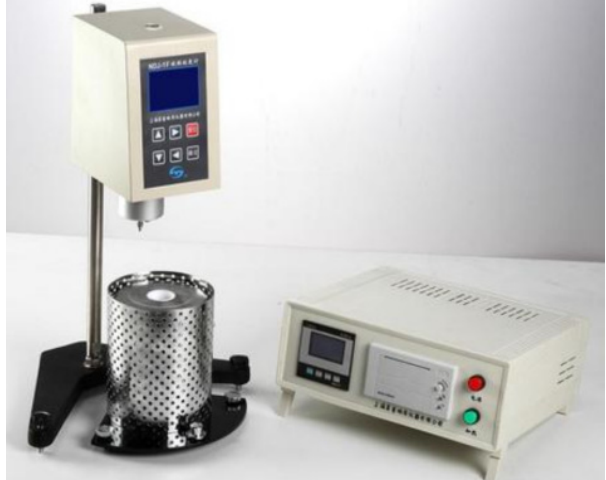
Figure 4. Brookfield rotational viscometer, which consists of two parts: a temperature control system and a shear rate control system.